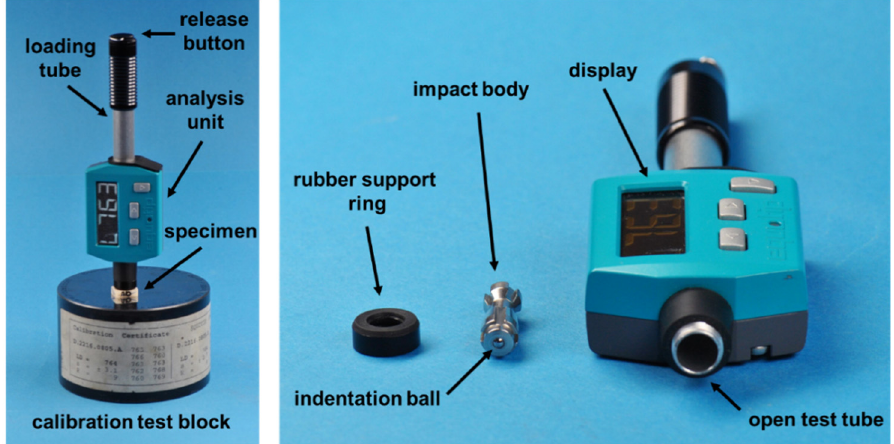
Figure 2. HLD test device (Equotip Piccolo 2, Proceq SA, Schwerzenbach, Switzerland). Left side: Device placed together with specimen on the calibration test block; right side: disassembled HLD test device.